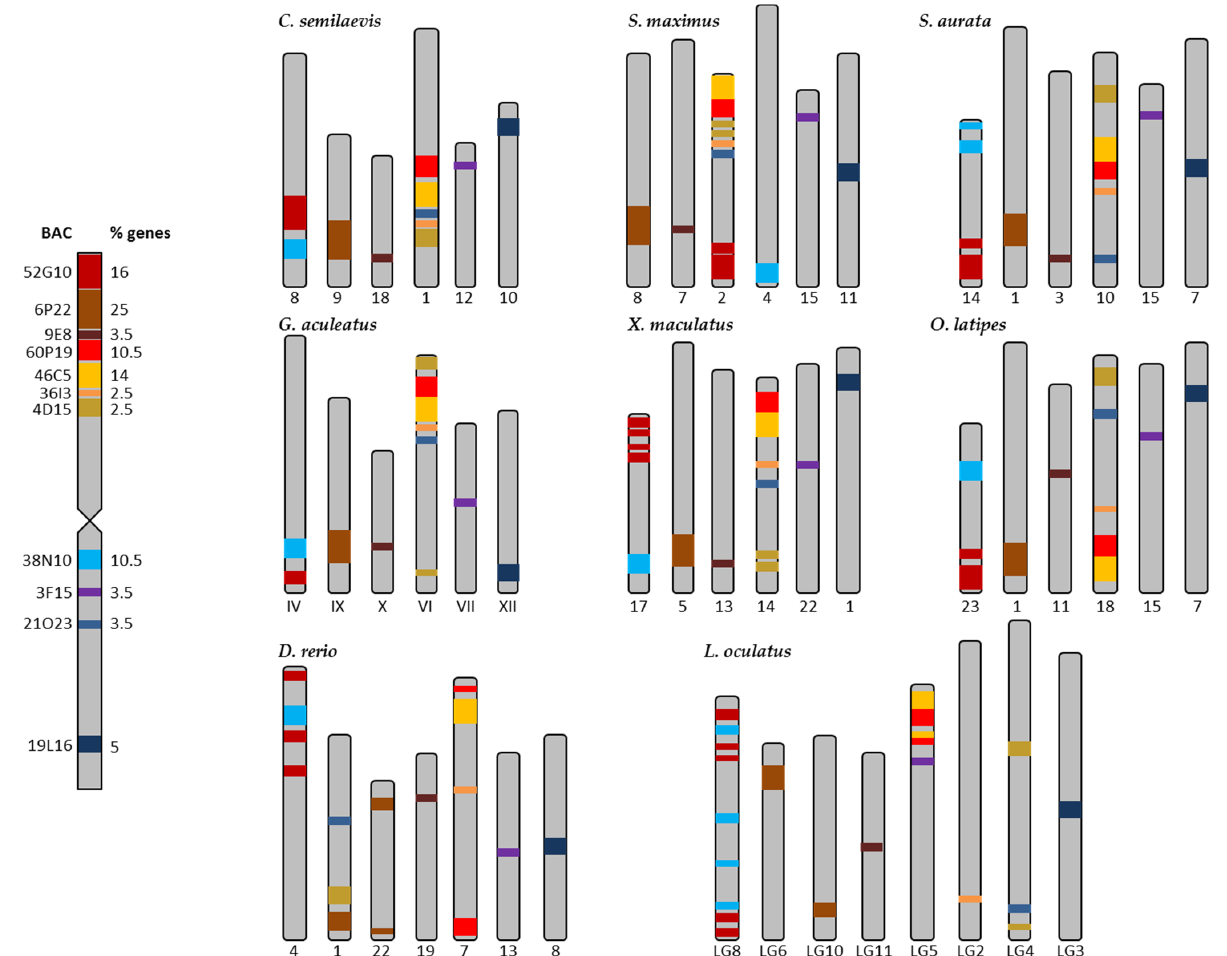
Figure 3. Distribution of the BACs of the metacentric chromosome 2 of Solea senegalensis in the chromosomes of the eight reference fish species: Cynoglossus semilaevis , Scophthalmus maximus , Sparus aurata , Gasterosteus aculeatus , Xiphophorus maculatus , Oryzias latipes , Danio rerio, and Lepisosteus oculatus . The colors represent the different BACs. % of genes is referred to the number of genes in each BAC, respective to the total of the genes in chromosome 2 (85 genes).